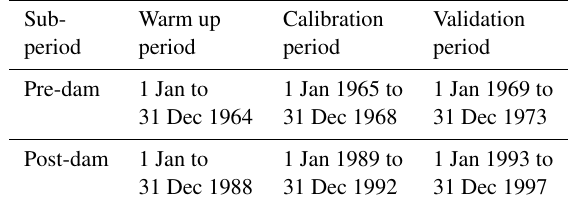
Table 1. Calibration and validation